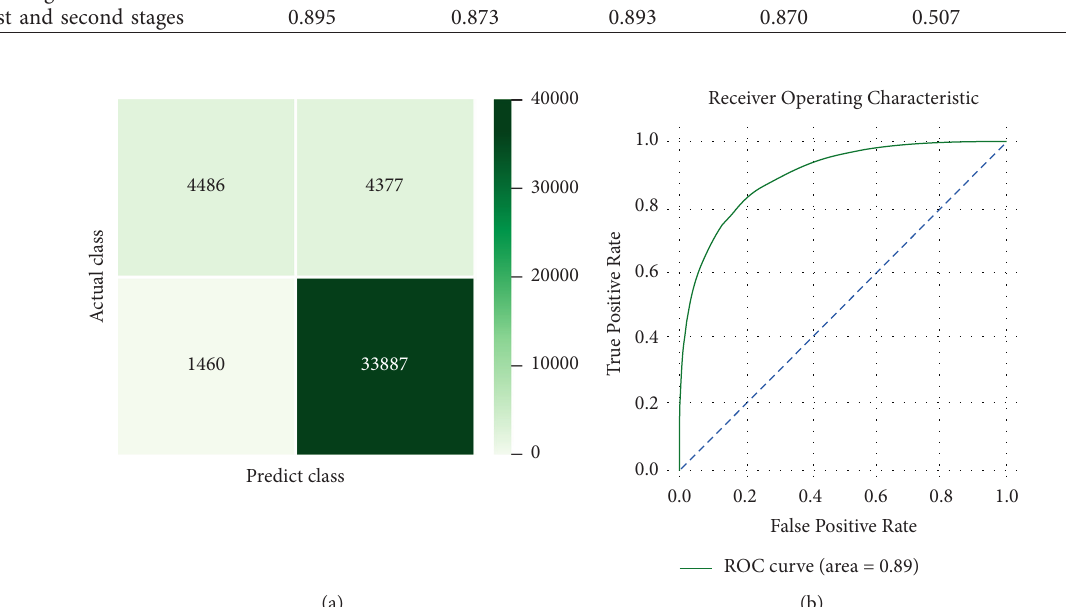
Figure 3: The confusion matrix and ROC of the XGBoost model. (a) The confusion matrix of the test data. (b) The ROC curve of the test